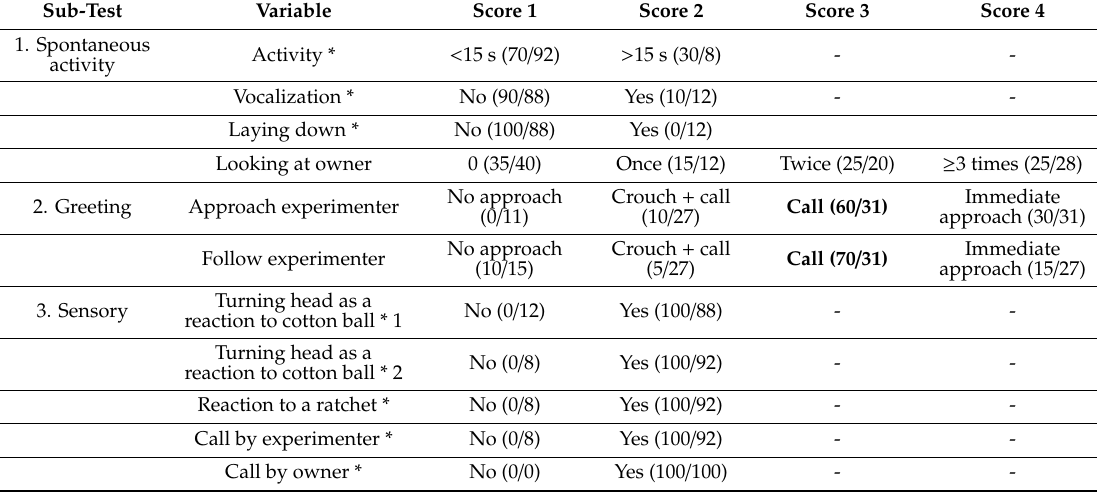
Table 1. Subtests, variables, definitions of scores, and proportions of subjects within age category (young / old). Variables lacking variation within a row (i.e., > 70% of dogs show a single type of behavior) are marked with an asterisk (*). Significant young vs. old proportion di ff erences are highlighted in bold ( p <